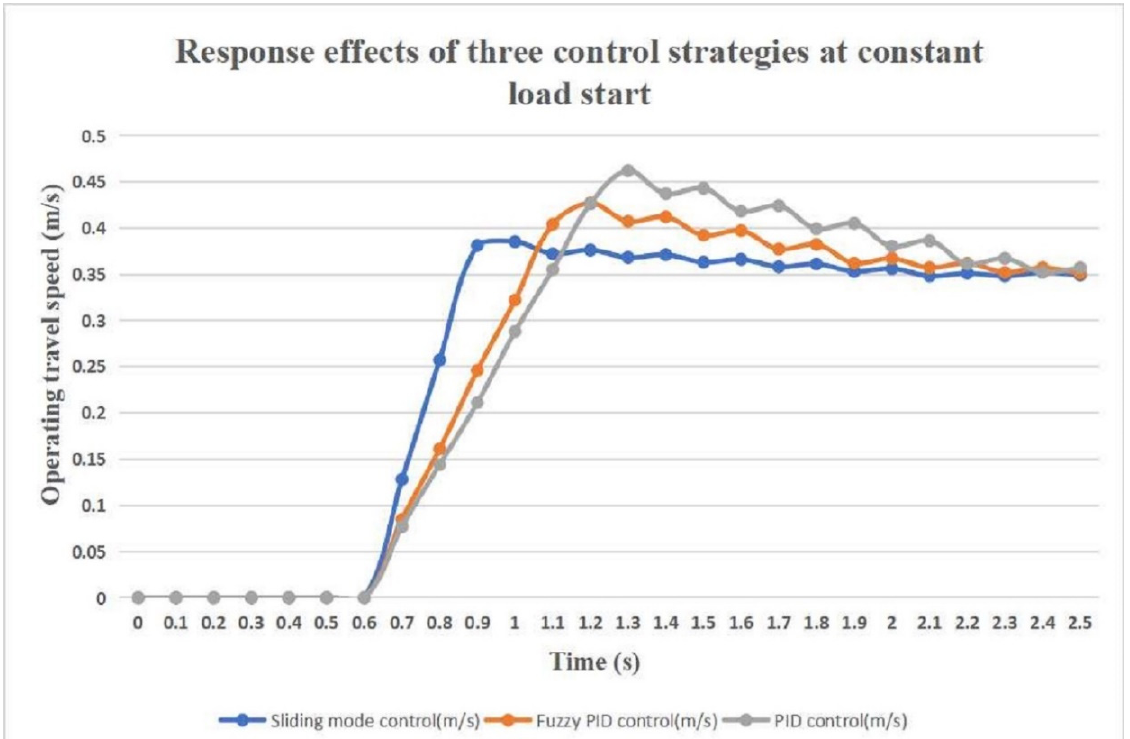
Figure 18. Response effects of three control strategies for constant load starting of harvester.